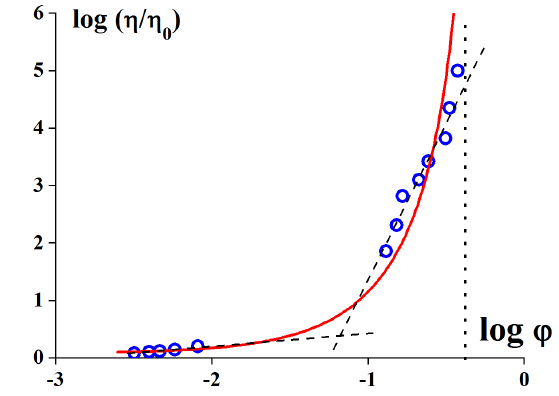
Figure 2: Evolution of the viscosity for samples that were well iso- lated from contact with environmental air